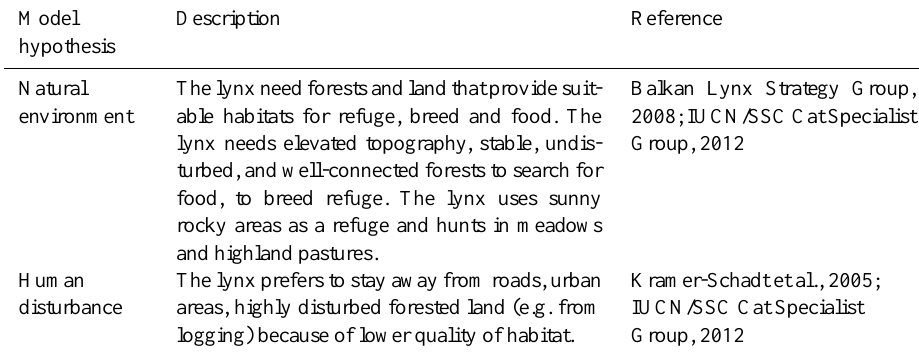
Balkan Lynx Strategy Group, 2008; IUCN/SSC Cat Specialist Group, 2012 Kramer-Schadt et al.,